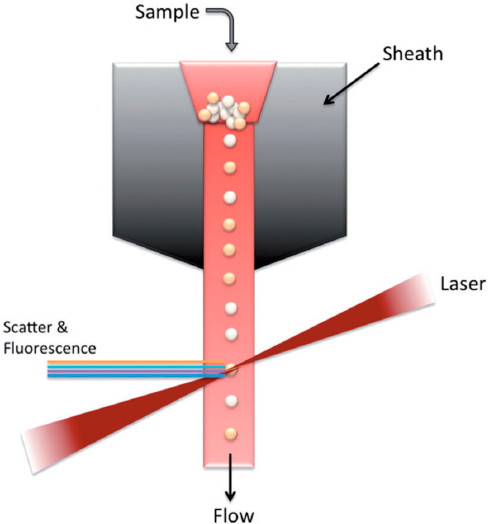
Figure 16. Basic Working Principle of a Flow Cytometer. “Reproduced from [99] with the permission of Taylor & Francis”.